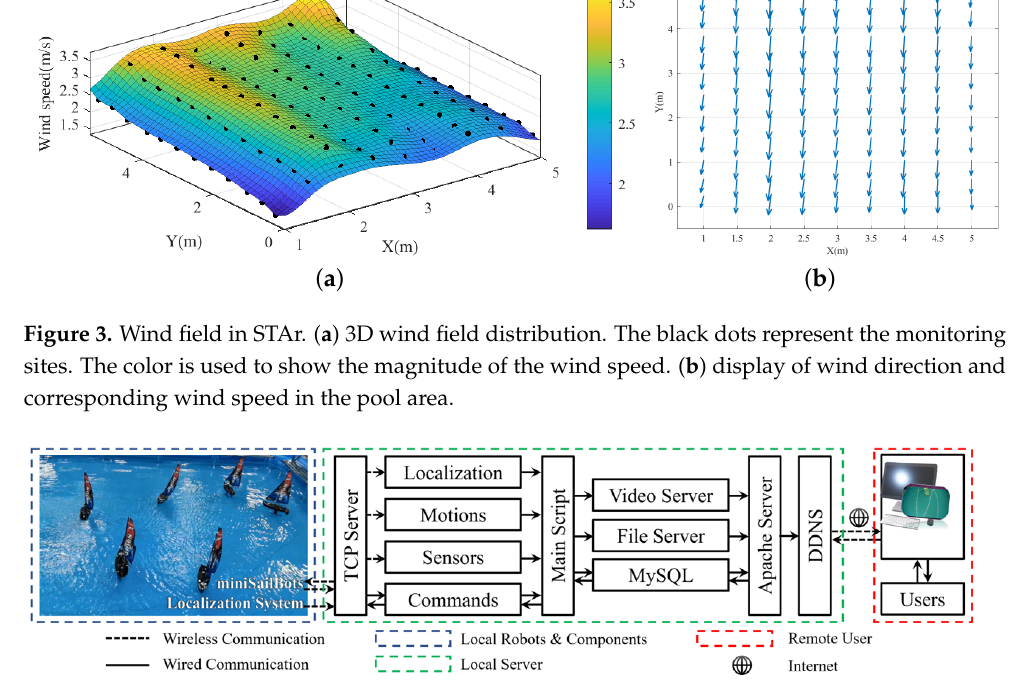
Figure 4. Internet server framework of STAr. The framework consists of local robots and devices, local server and remote users. The local server plays the part of connection between local robots and remote